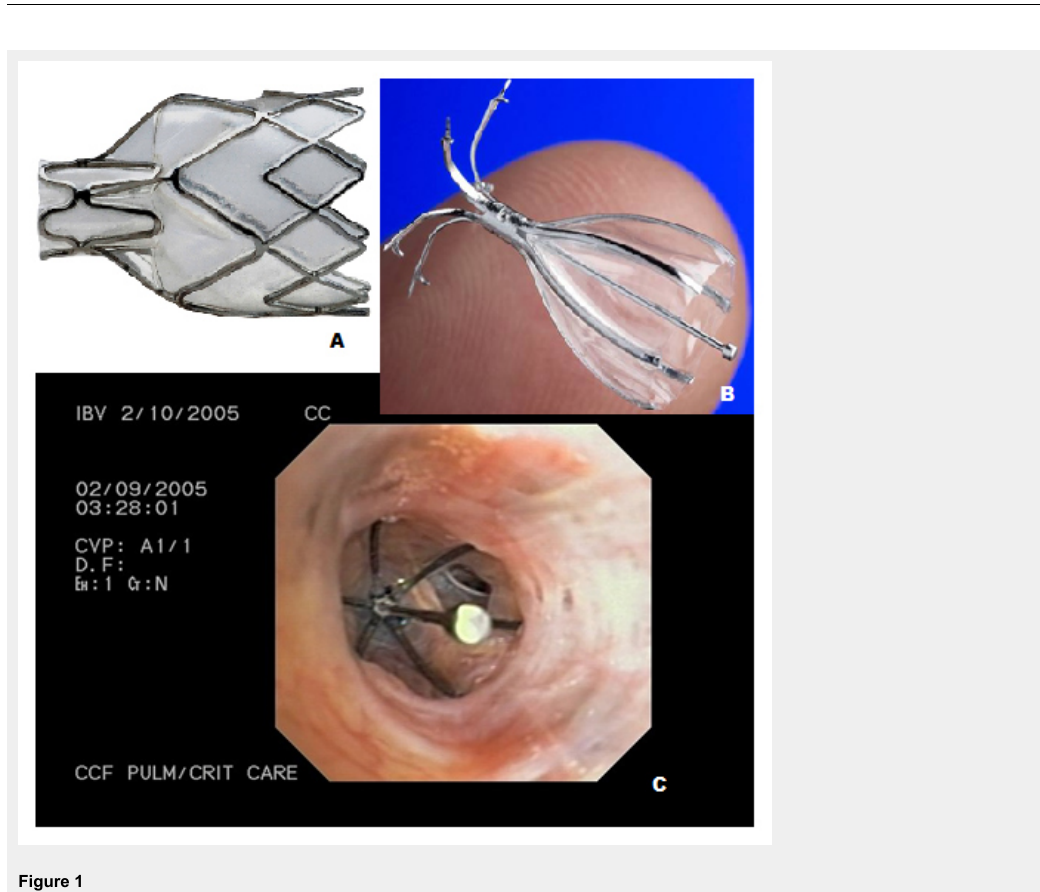
Figure 1 A– Pulmonx intrabronchial valve; B- Spiration valve; C- Bronchoscopic view of the Spiration valve in situ.